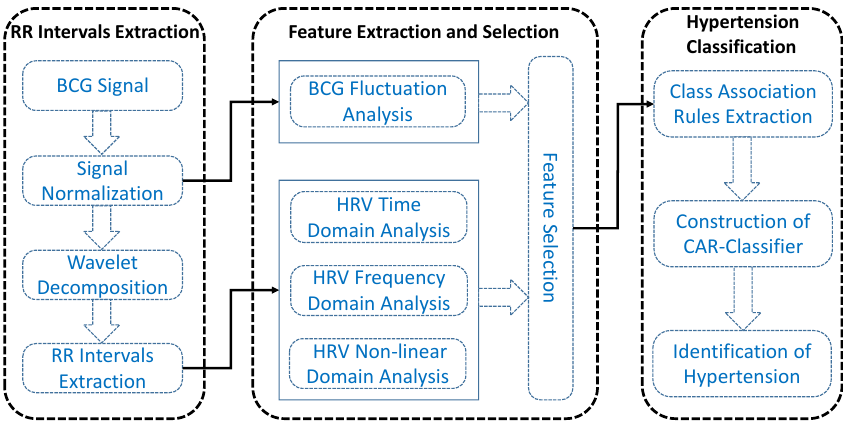
Figure 2. The framework of the proposed hypertension identification method.